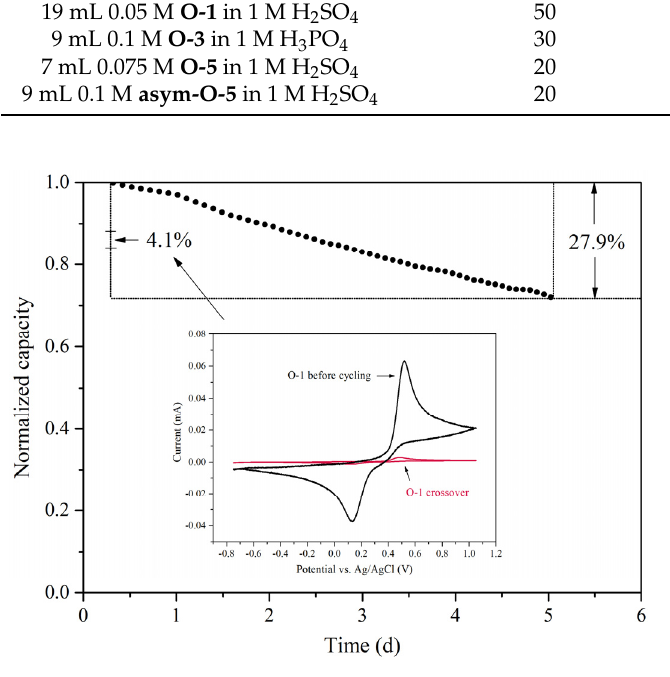
Figure A3. Discharge capacity fade over time. The cell employed 0.5 M O-1 in 1 M H 2 SO 4 as the catholyte and 1.6 M V(III) as the anolyte. Charge/discharge current was set at 200 mA. The inserted figure is the cyclic voltammogram of O-1 before cycling and its crossover to the anode side after cycling.